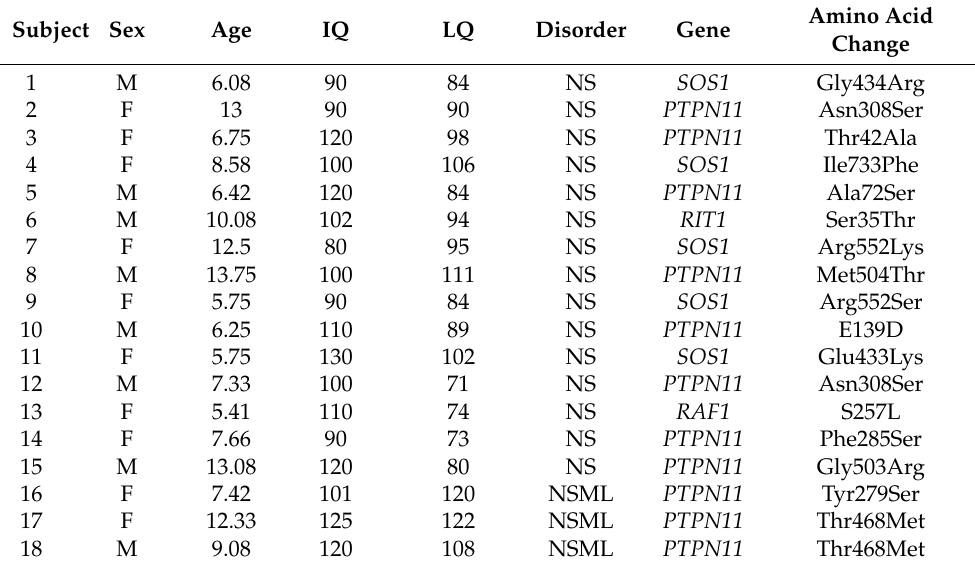
Table 1. Molecular characterization of the study cohort. Legend. F = female, M = male, IQ = Non- verbal intellectual quotient, LQ = Lexical quotient, NS = Noonan Syndrome, NSML = Noonan syndrome with multiple